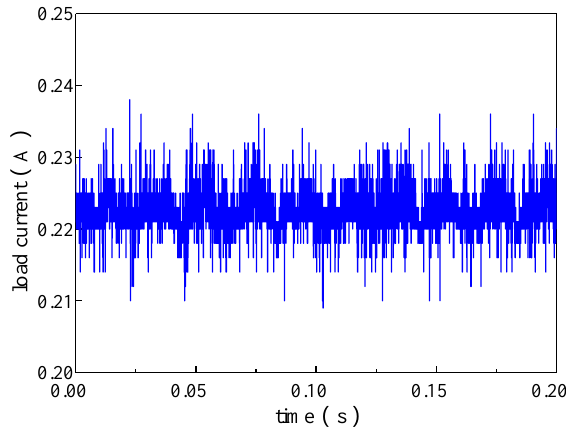
Figure 16. Output current waveforms during state generating test.